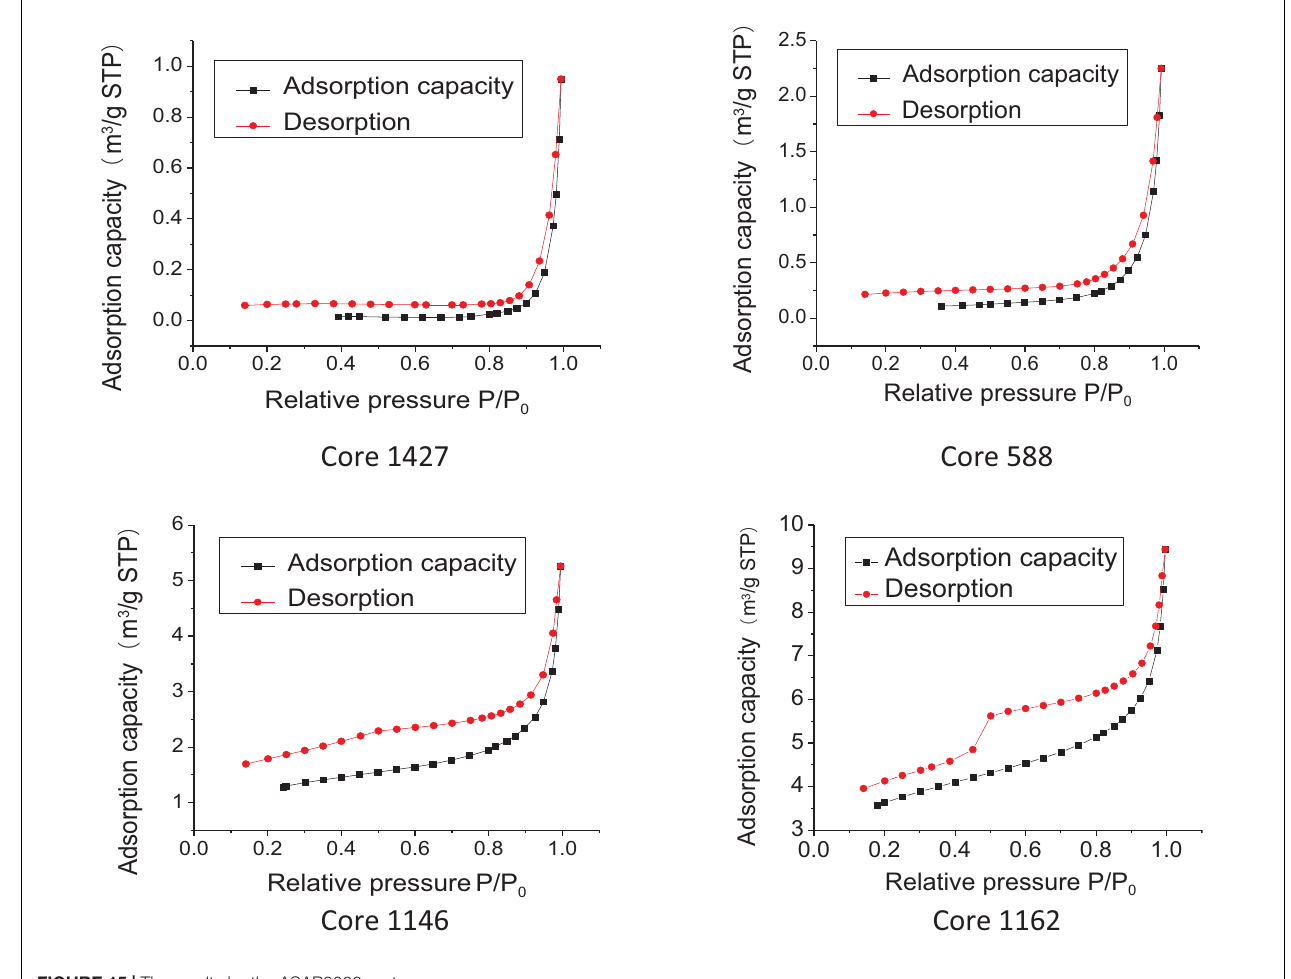
FIGURE 15 | The results by the ASAP2020